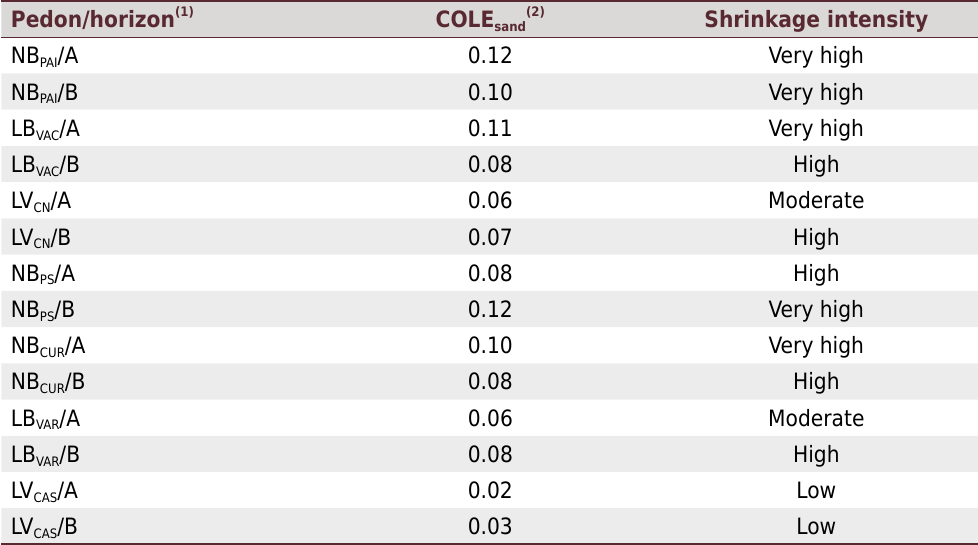
Table 6. Soil shrinkage intensities, using the classification obtained for Vertissolos with the Saran Resin Method (Taboada, 2004) as: low (COLE <0.03), moderate (COLE from 0.03 to 0.06), high (COLE from 0.06 to 0.09), and very high (COLE